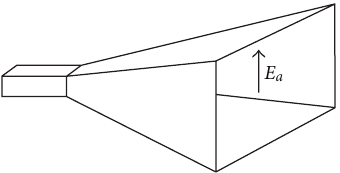
Figure 1: A typical horn antenna showing the orientation of the electrical field component of the microwave energy in the antenna’s